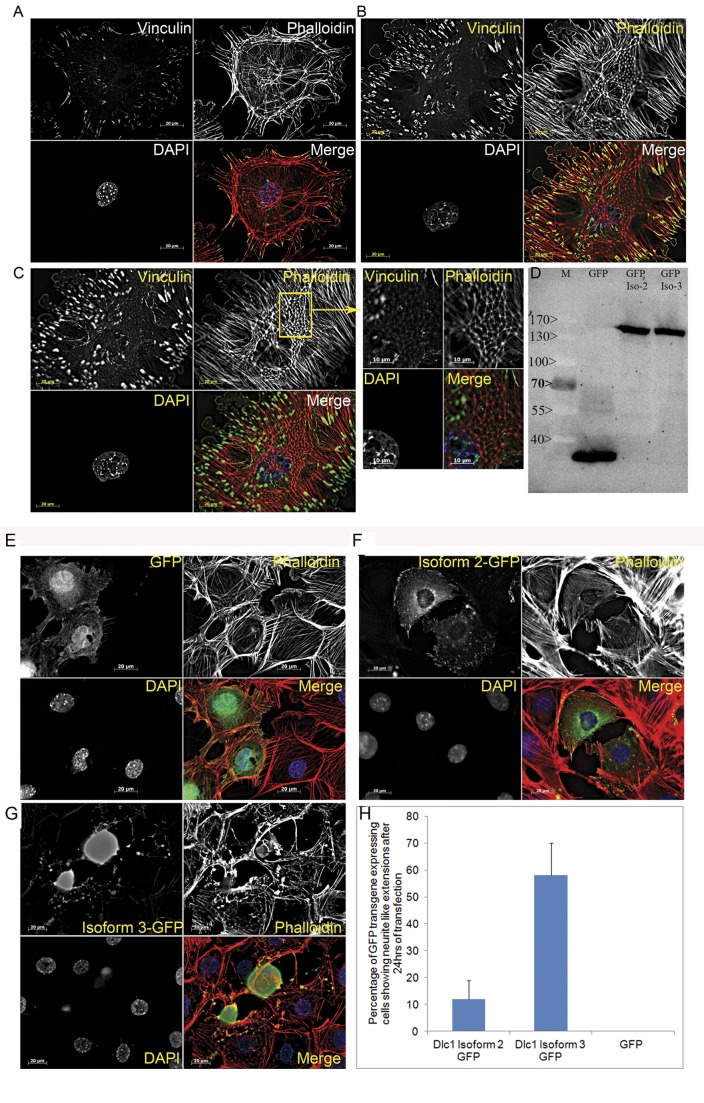
Comparison of stress fibre formation in thymic epithelial and TEC cells and effect of GFP tagged Dlc1 isoform 2 and 3 expression on cell morphology and stress fibre formation.(A) Normal thymic epithelial cell showing stress fibre formation in the form of an annular transverse arc. (B) Thymic epithelial carcinoma cell (Z stack-1) showing extensive ventral stress fibre formation and increasing frequency of focal adhesions, (C) the same tumour cell showing a different structural organization of vinculin and actin at Z stack -7 on the dorsal surface of the cell. (D) Western blot showing transient expression of Dlc1 isoform 2 & 3 proteins tagged with C terminal GFP in the TEC cell line. Thymic epithelial carcinoma cells transfected with (E) pEGFP C1 vector, (F) Dlc1 isoform 2 GFP construct; (G) Dlc1 isoform 3 GFP construct. (H) Bar diagram representing the relative number of cells that are showing neurite like extensions expressed as a percentage of total GFP transgene expressing cells.